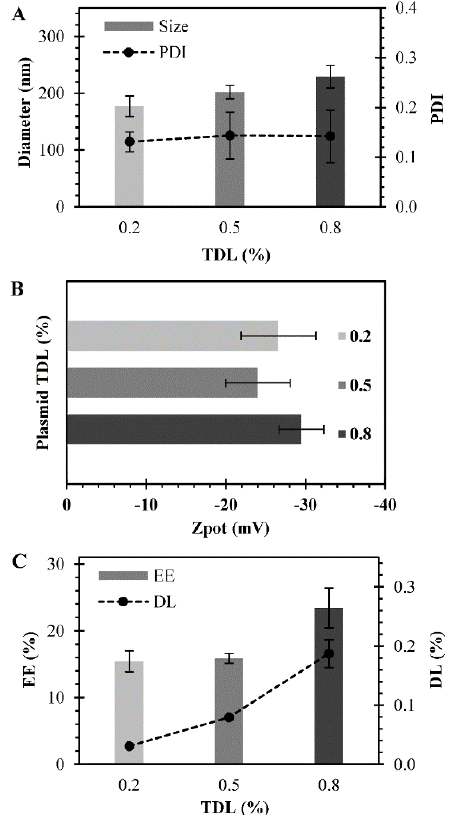
Figure 3. Characteristics of pDNA ‐ NP prepared at different theoretical pVAX1 ‐ NH36 loadings (pVAX1 ‐ NH36 TDL). ( A ) Particle diameter and polydispersity index; ( B ) zeta potentials; ( C ) EE and DL for different pVAX1 ‐ NH36 with TDL of 0.2% ( ), 0.5% ( ) and 0.8% ( ) were evaluated. Data represent mean ± SD ( n = 3).